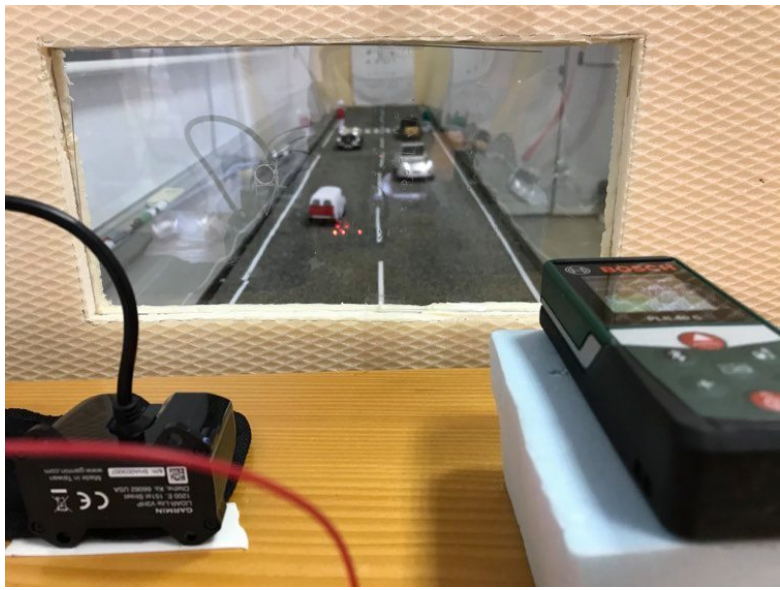
Figure 13. Lidar and